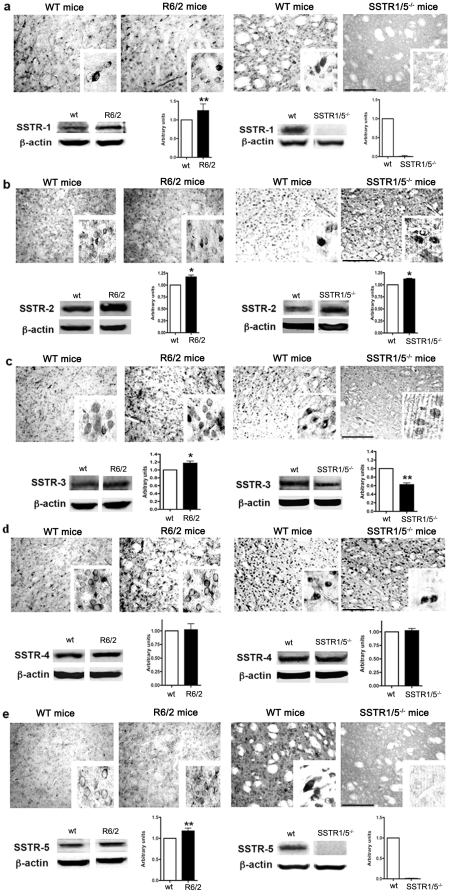
Peroxidase immunohistochemistry illustrating the changes in distribution pattern of SSTR1-5 in striatum of R6/2 and SSTR1/5−/− mice.SSTR1(53 kDa) like immunoreactivity increased in striatum of R6/2 mice and abolished completely in SSTR1/5−/− mice (a). SSTR2 (57 kDa) like immunoreactivity was increased in R6/2 and SSTR1/5−/− mice (b). SSTR3 (60 kDa) expression was increased in R6/2 while it decreased in SSTR1/5−/− mice striatum (c). Comparable expression of SSTR4 (44 kDa) was observed in both R6/2 and SSTR1/5−/− mice brain (d). SSTR5 (58 kDa) expression was selectivley higher in R6/2 mice brain than wt and receptor like immunoreactivity was not detected in SSTR1/5−/− mice (e). Data presented as mean ± SD (SSTR1/5−/−, n = 5 and R6/2 mice, n = 3) in comparison to wt mice brain, *P<0.05, ** P<0.01. Scale bar = 20 µm panel a–e and 5 µm for inset.